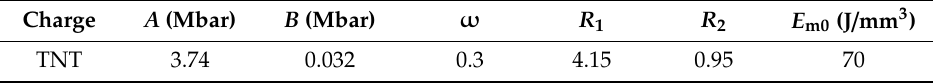
Table 5. Jones–Wilkins–Lee (JWL) model parameters of the TNT charge